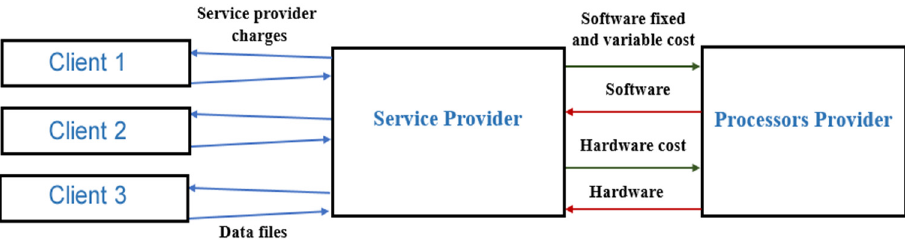
Figure 1. Data batching service network.